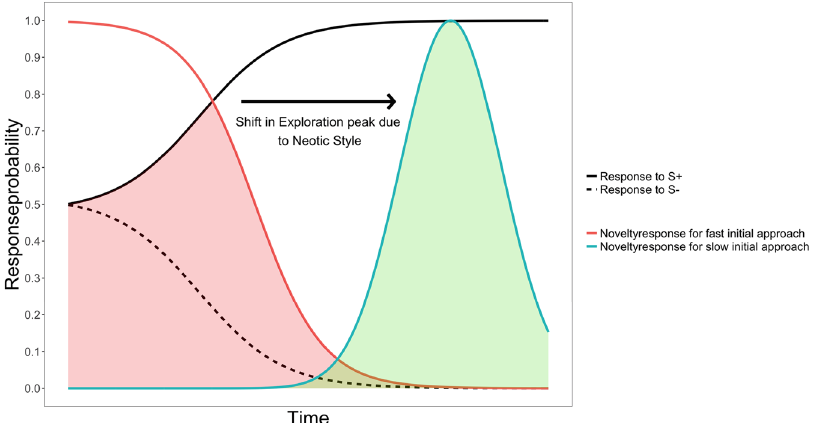
Figure 1. Theoretical model illustrating the shift in exploration-probability dependent on neotic style; solid- and perforated black lines indicate assumed responses to baseline stimuli (S + and S − ) throughout the course of learning; coloured lines represent proposed total novelty response probability for individuals approaching novelty fast or slow over time, with assumed normal distribution, if novel stimuli are non-rewarded; shaded areas denote corrected total novelty responses; hence, we assume the total amount of corrected novelty responses (shaded area) as well as the height of the peak to be dependent on how explorative an individual is and its general learning capacity, whereas the location of the peak on the time axis to be defined by what neotic style an individual